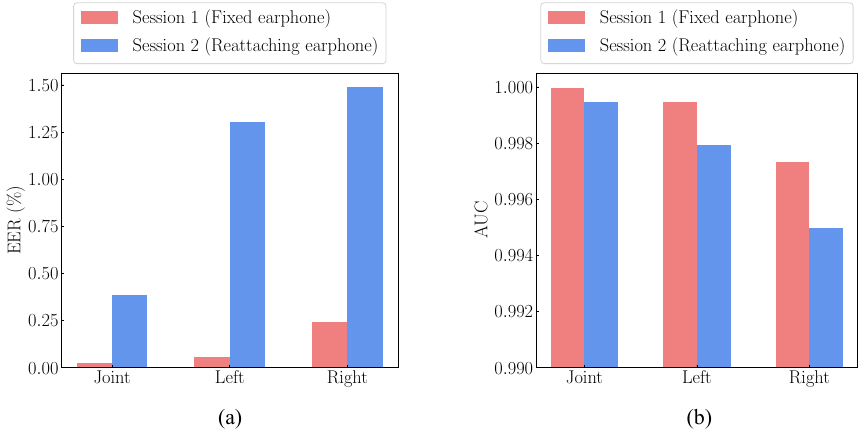
Figure 12. Comparison of EER and AUC for Sessions 1 and 2. ( a ) EER. ( b )